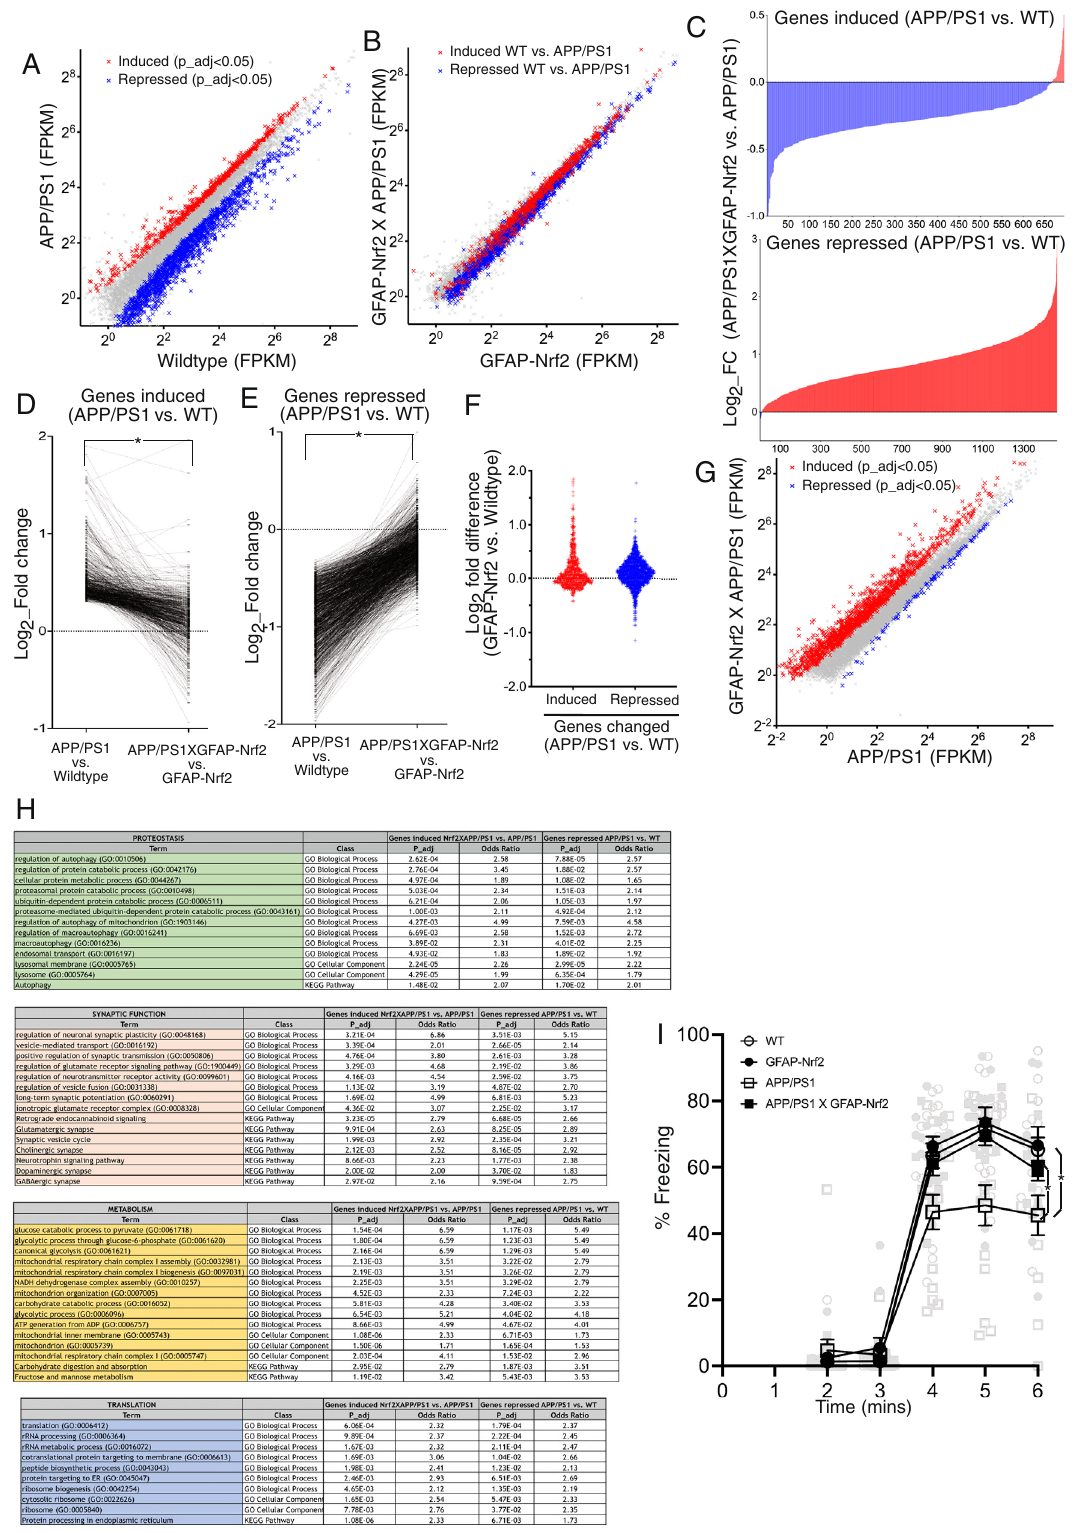
the case of microglia 22 , it is possible that cumulative genetic risk determines the response of astrocytes to Aß (direct or indirect e.g. via microglia), thus in fl uencing the downstream cascade that can lead either to a spectrum of outcomes ranging from aggressive AD to apparent tolerance of a high Aß burden in the absence of cognitive symptoms 63